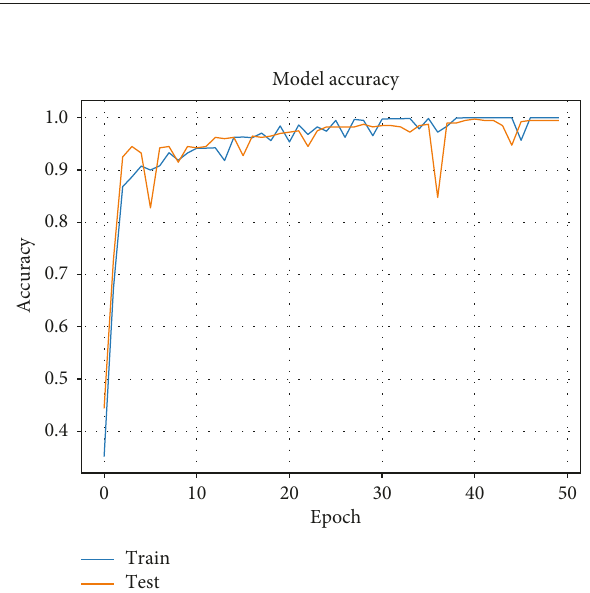
Figure 6: Accuracy change of training and testing data.